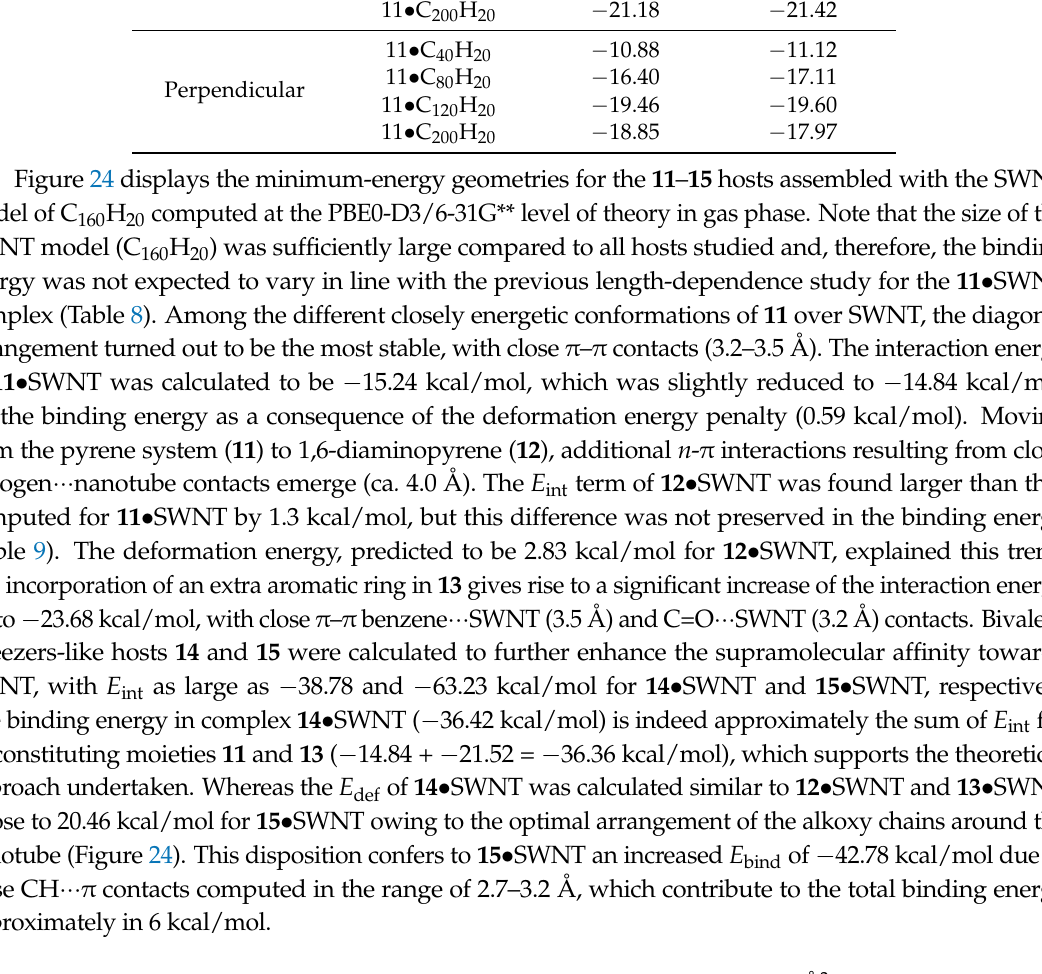
Table 9. Energy parameters (kcal/mol) and intermolecular contact area (CA, in Å 2 ) calculated for the interaction between hosts 11 – 15 and SWNT guests at the CP-corrected PBE0-D3/6-31G**+ E ABC level